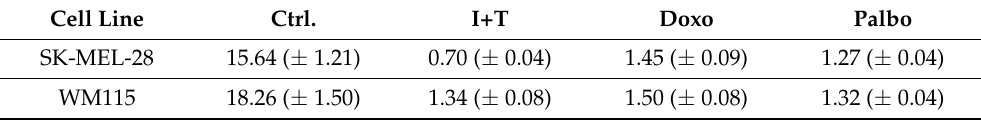
Table A2. The number of cells ( × 10 6 ) that produced the supernatants, which were then analyzed with Proteome Profiler arrays (Figure 5a,b). The mean value ( ± s.d.) is indicated.